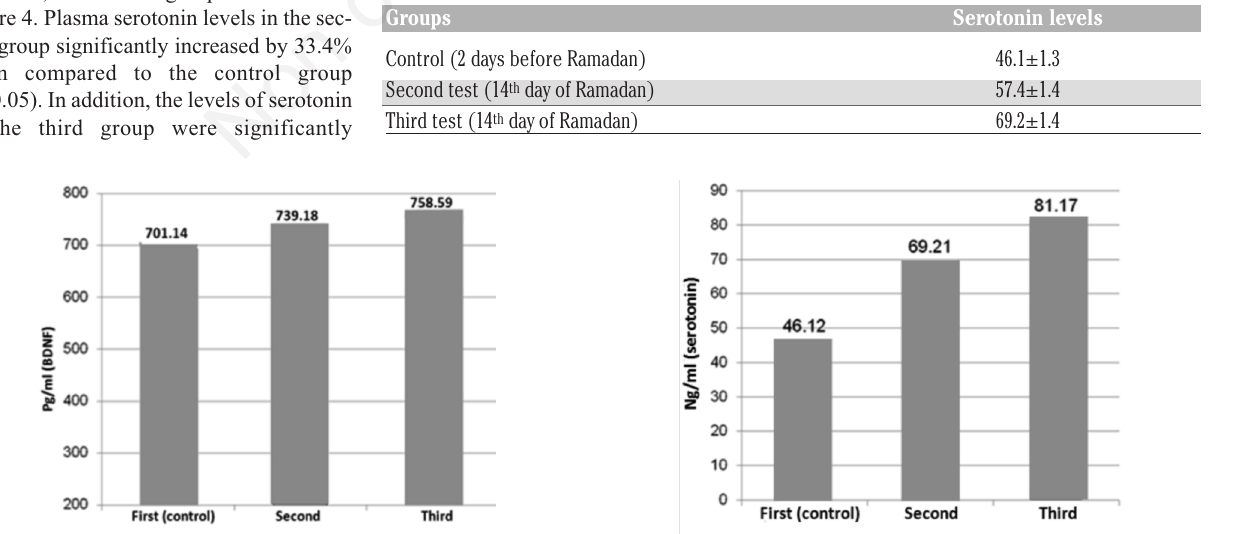
Table 4. Effect of fasting on serotonin levels in the group of women only. All data are expressed as means±standard error of mean; P<0.05.